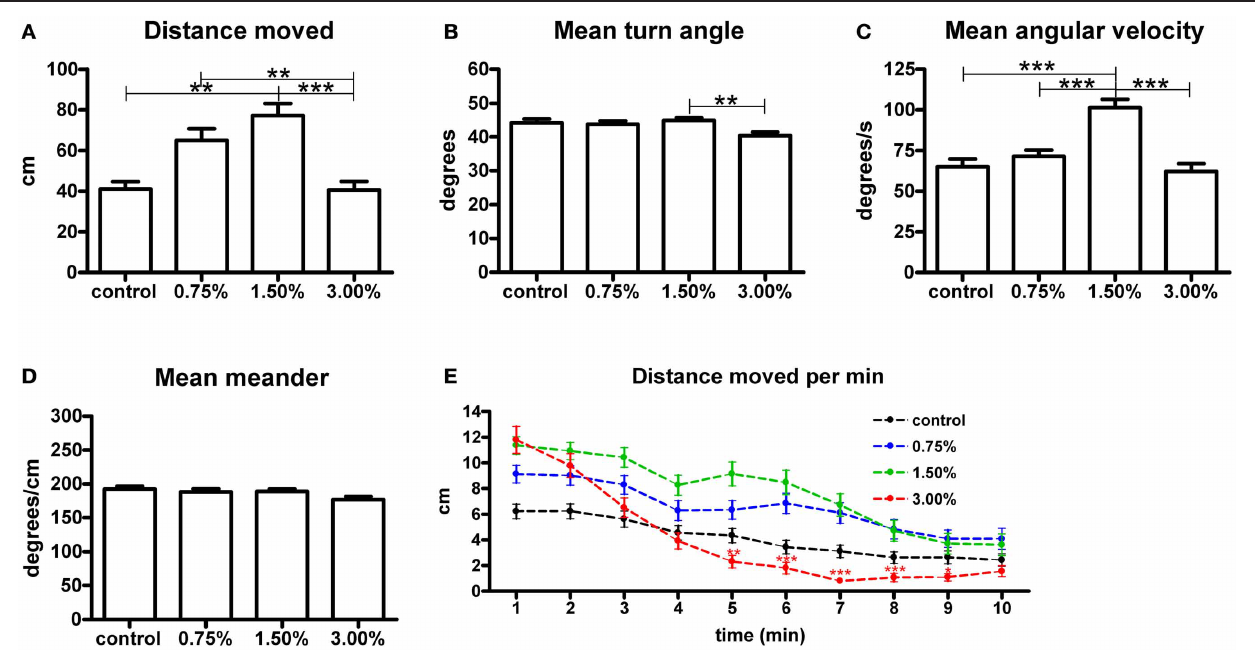
FIGURE 1 | The effect of 0.75%, 1.50% and 3.00% ethanol concentration on locomotion in larval zebrafish during the first 10 minutes after exposure. A significant increase can be seen in the total distance moved (A) up to a 1.50% concentration, with a 3.00% concentration having no apparent change on total distance moved [ F ( 3 , 213 ) = 8 . 304, p < 0 . 0001]. The angular velocity (C) is also significantly altered in the 1.50% group [ F ( 3 , 213 ) = 16 . 18, p < 0 . 0001]. We could also see a significant difference in turn angle (B) between the 1.50% and 3.00% groups, but this observation was inconsistent across repeats and therefore unlikely to be of any relevance [ F ( 3 , 213 ) = 4 . 046, p = 0 . 0080]. No differences are seen in meander (D) [ F ( 3 , 213 ) = 2 . 331, p = 0 . 0753]. Statistics were done using 1-way